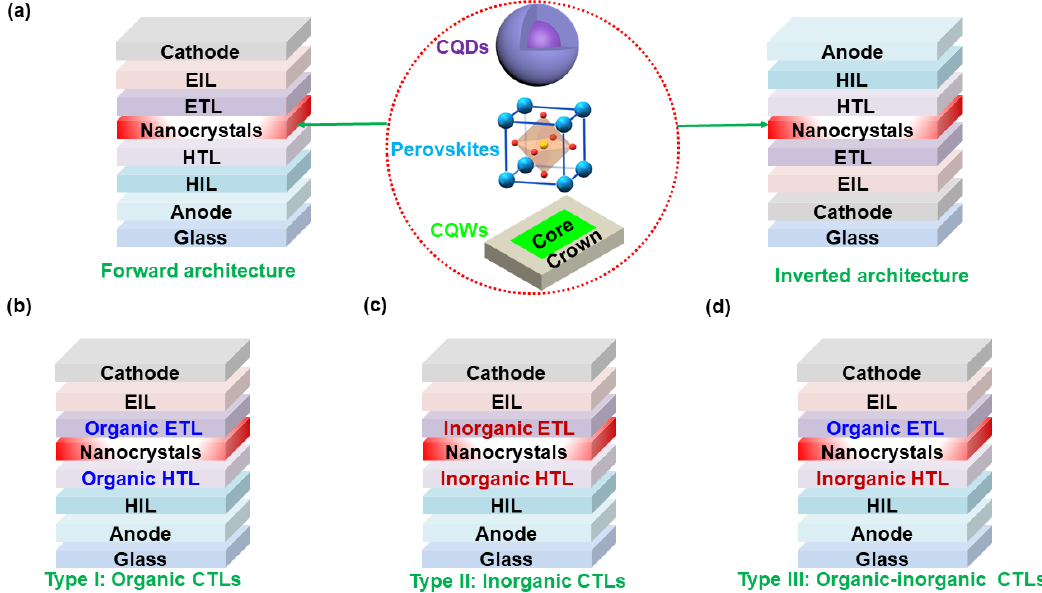
Figure 1. Diagram of device architectures for nanocrystal light-emitting diodes (LEDs). ( a ) Forward and inverted device architectures, where core/shell colloidal quantum dot (CQD), perovskite, and core/crown colloidal quantum well (CQW) material structures are used to clarify the corresponding nanocrystal emitters. EIL is the electron injection layer. ( b ) Nanocrystal LEDs with organic charge transporting layers (CTLs) (Type I). ( c ) Nanocrystal LEDs with inorganic CTLs (Type II). ( d ) Nanocrystal LEDs with organic-inorganic hybrid CTLs (Type III).